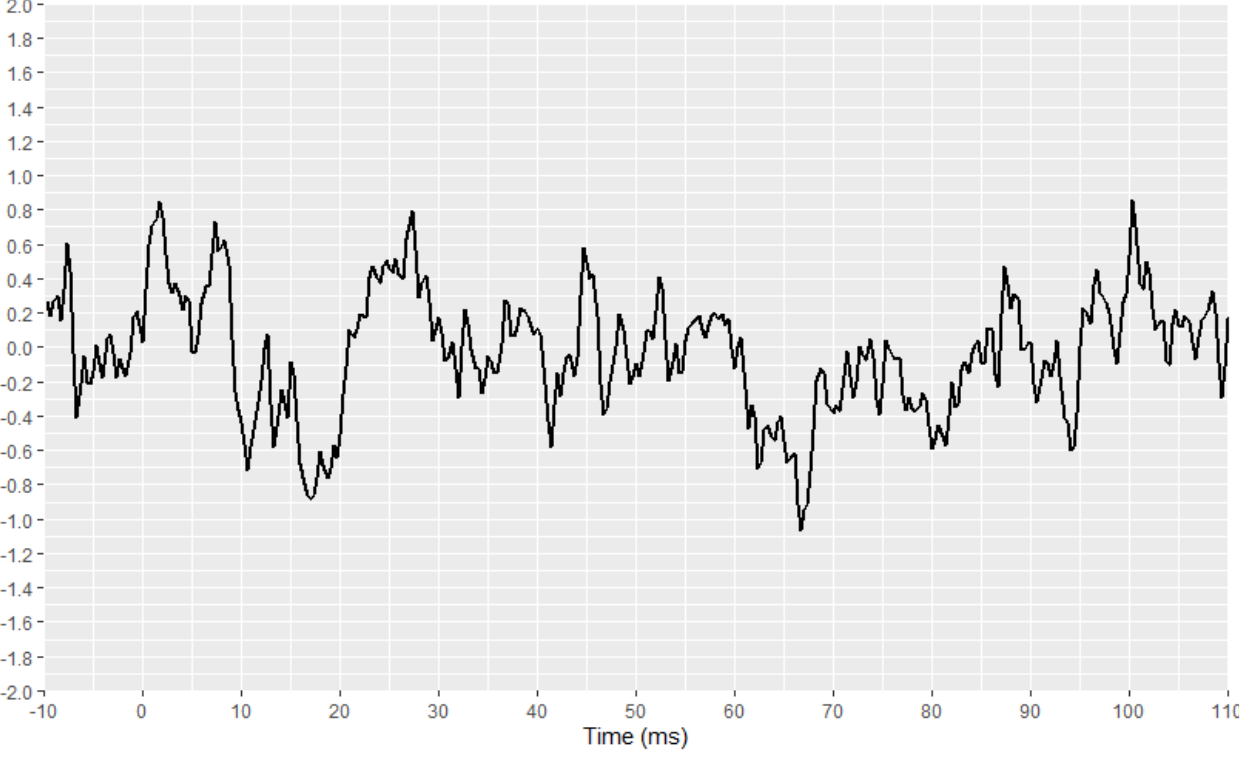
Figure 3. Visualisation of an AMLR waveform from raw data (in black).